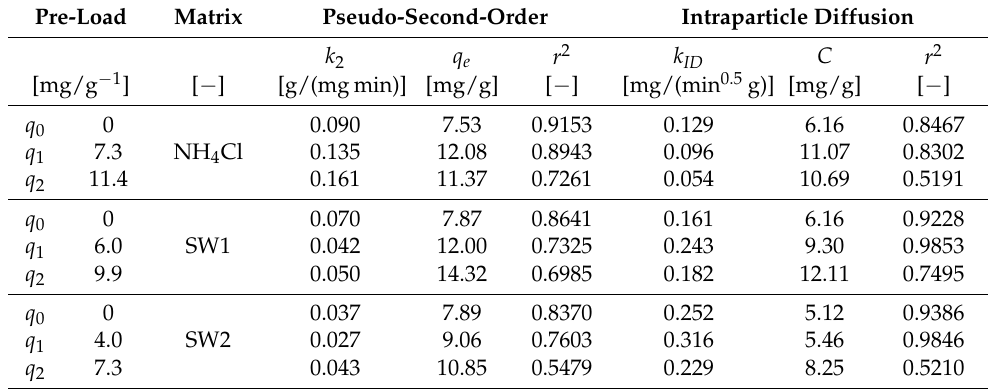
Table 9. Coefficients of the sorption kinetics according to the PSO and ID models of CCP 20 with different pre-loads (specific sorbent dosage: 0.1 g CLI /mg NH4-N ; T = 307 K; NH4Cl